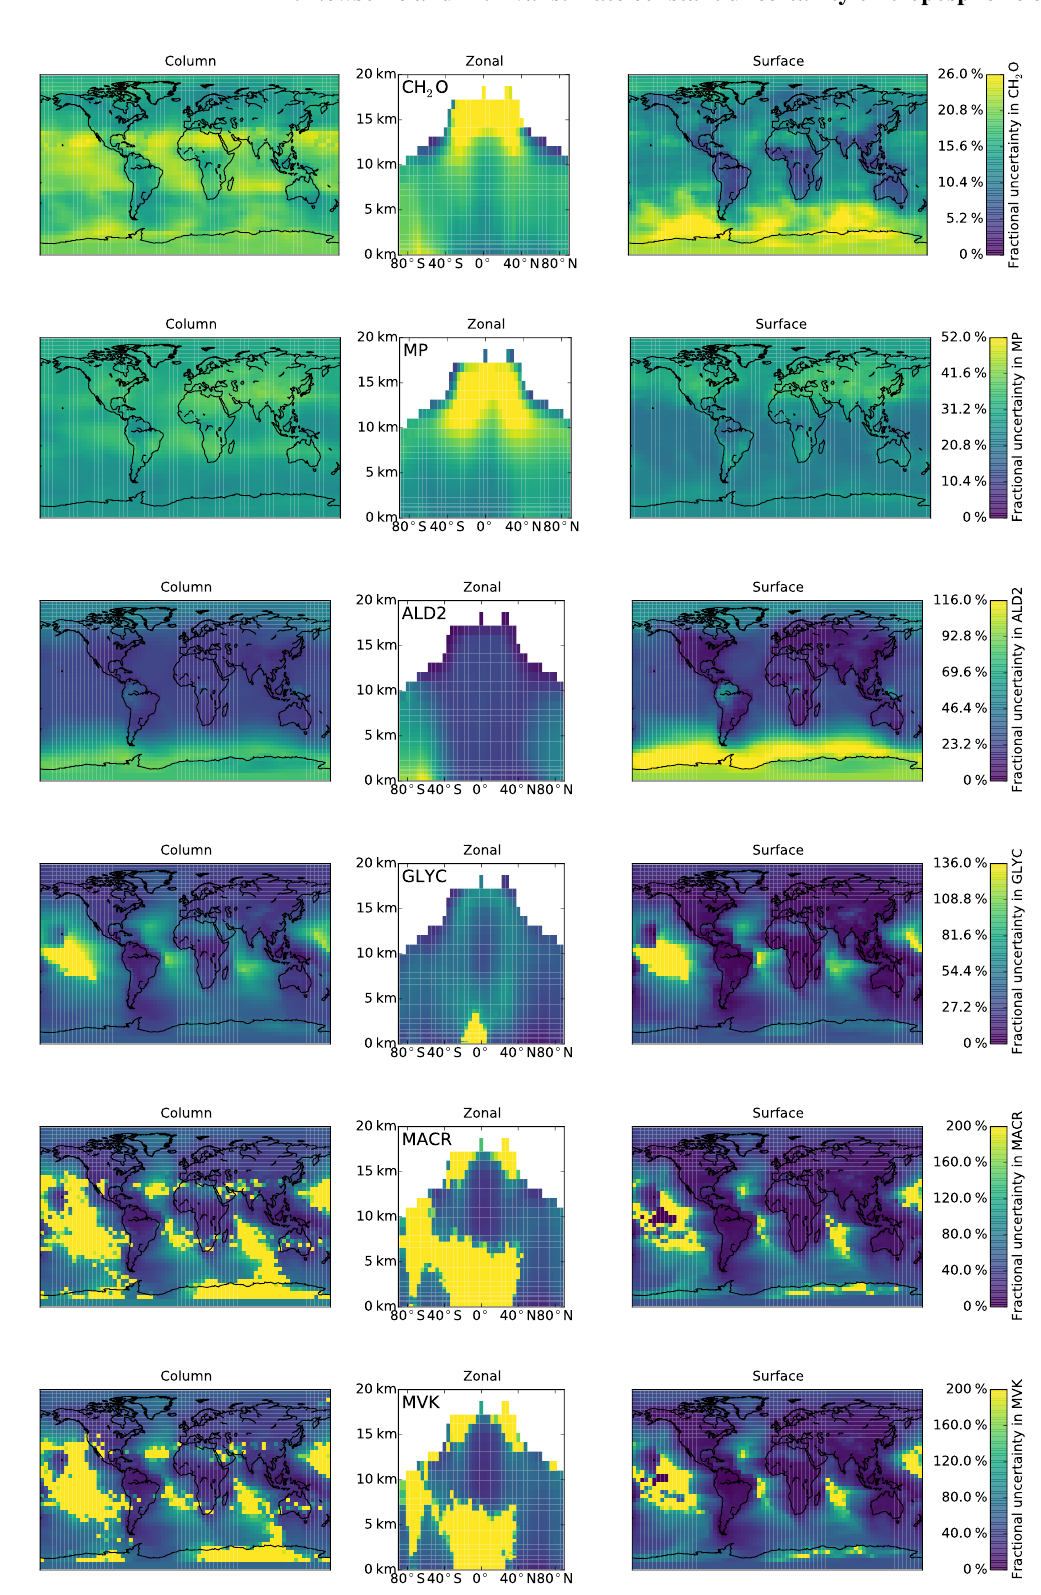
Figure 7. Other organics: total 1 σ uncertainty in the concentrations of CH 2 O, MP (methyl hydroperoxide), ALD2 (acetaldehyde), GLYC (glycolaldehyde), MACR (methacrolein) and MKV (methyl vinyl ketone) from the addition in quadrature of the individual reaction uncer- tainties. “Column” covers the tropospheric